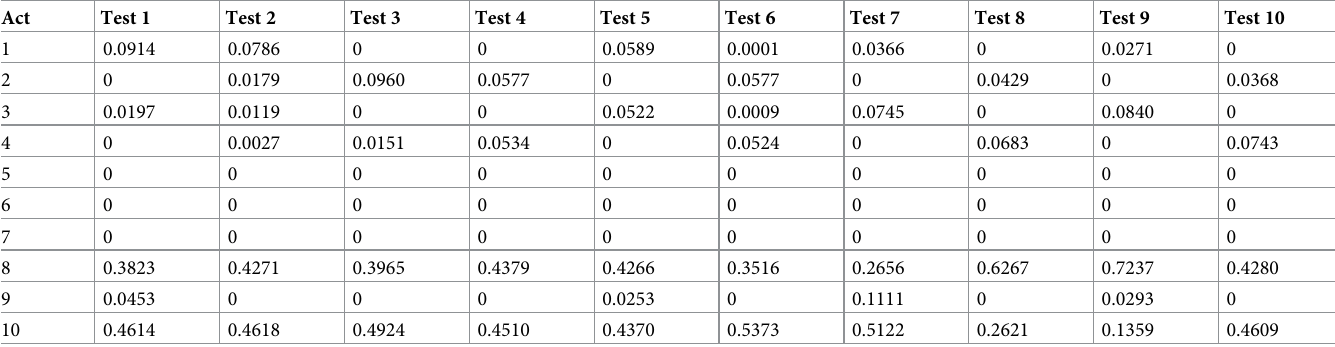
Table 3. Simulation results for the population in Fig 2 with two subpopulations P 1 and P 2 , each having a preferred subset of activities. Act